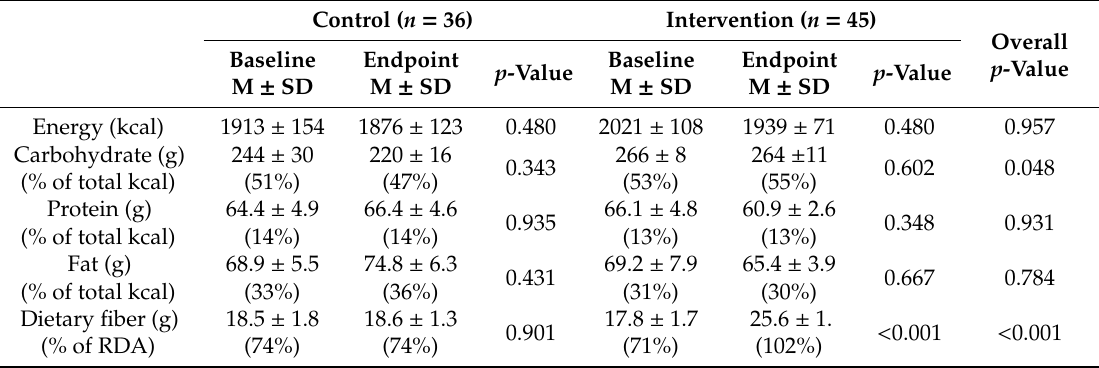
Table 4. Macronutrient intake of the control and intervention groups at baseline and endpoint during Ramadan.